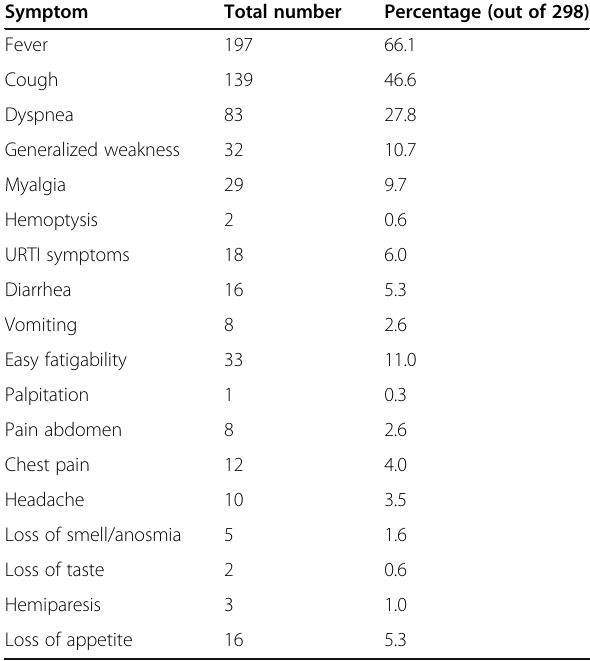
Table 2 Presenting symptoms of patients with